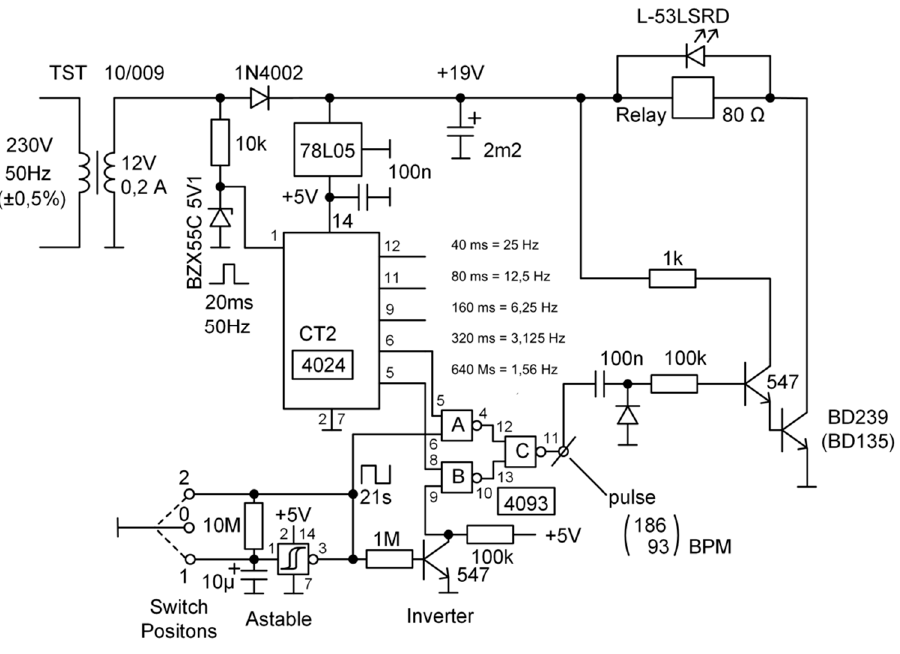
Figure 3. The general scheme of the electrical circuit for the realized FHRS.